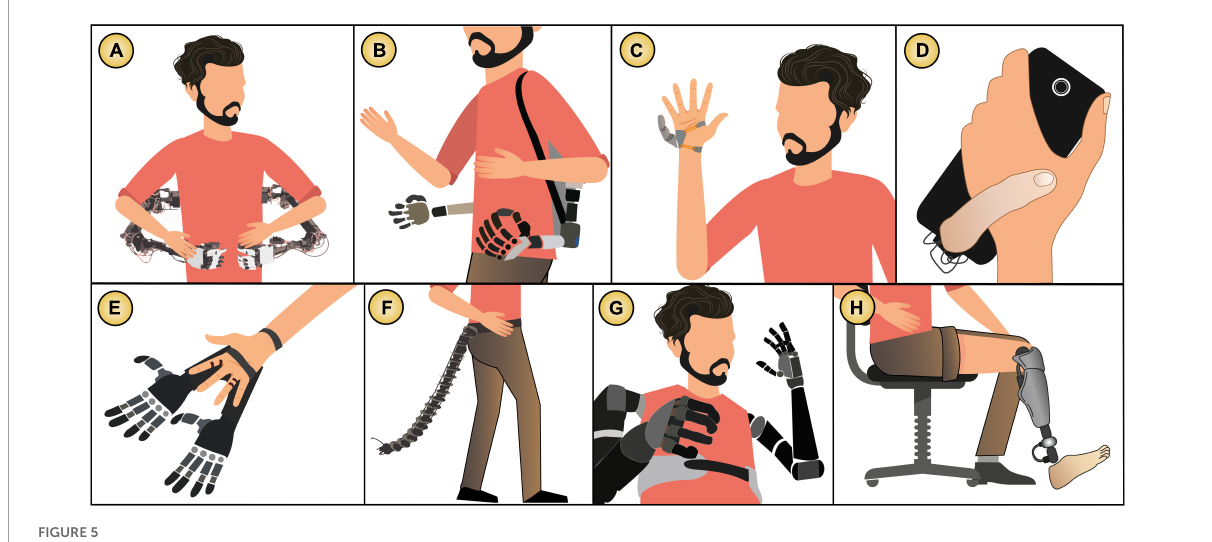
FIGURE5 Examples of body augmentation technology: (A,B) Arms attached to the user’s body (Sasaki et al., 2017; Gourmelen et al., 2019), (C) bionic second thumb (Kieliba et al., 2021), (D) extra finger assisting phone interactions (Teyssier et al., 2018), (E) double bionic hand (Youbionic, 2017), (F) tail extension (Svanaes and Solheim, 2016; Nabeshima et al., 2019), (G) prosthetic bionic arms (Canepari, 2015), and (H) leg (Demarco, 2015). Images based on the original publications.